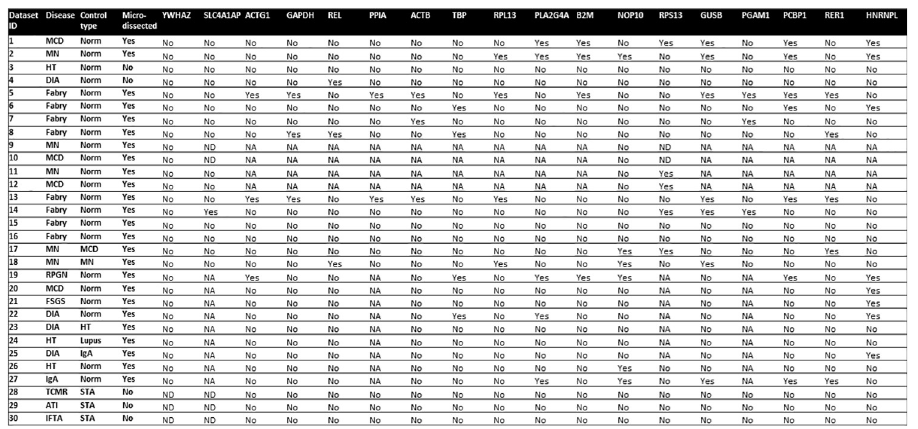
Fig 2. Results for all included reference genes from each dataset. MCD: Minimal change disease, MN: Membranous nephropathy, HT: Hypertension, DIA2: Diabetes type 2, FSGS; Focal segmental glomerulosclerosis, IGAN; IgA nephropathy, TCMR: t-cell mediated rejection, RPGN; Rapidly progressive glomerulonephritis, STA: stable allograft, ATI: acute tubular injury, IFTA: Interstitial fibrosis and tubular atrophy. In the columns under the gene IDs “Yes” refers to genes differentially expressed in control and test samples in the dataset. “No” refers to RG equally expressed in control and test samples in the defined dataset. Not available (NA) refers to RG not tested in specific datasets. Not detected (ND) refers to genes undetected in the specific